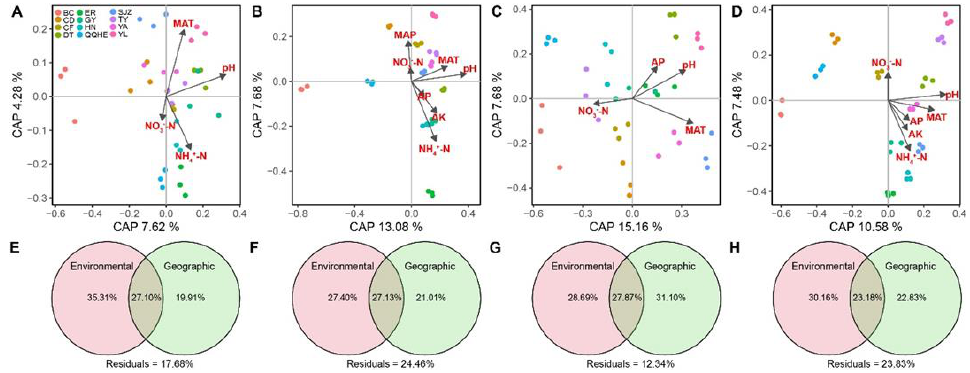
Figure 3. Effects of environmental variables on rhizosphere bacterial and fungal community turnover of the abundant and rare taxa in broomcorn millet fields. Constrained analysis of principal coordinates model showing significant factors that affecting rhizosphere bacterial ( A , B ) and fungal ( C , D ) community turnover of the abundant and rare taxa. Variation partitioning (% variation explained) of rhizosphere bacterial ( E , F ) and fungal ( G , H ) community turnover of the abundant and rare taxa in relation to combined environmental and geographic distance.